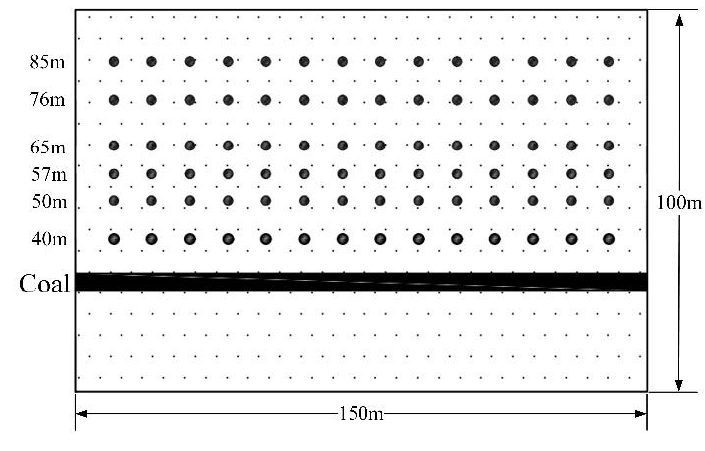
Figure 19. Model measurement ball point diagram.